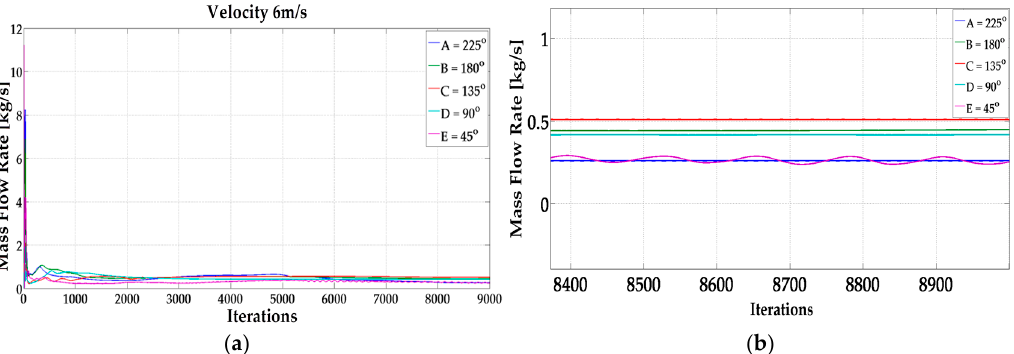
Figure 1. Convergence of air mass flow rate: ( a ) Monitoring of mass flow rate of air that gets into the room, ( b ) oscillations of the mass flow rate.